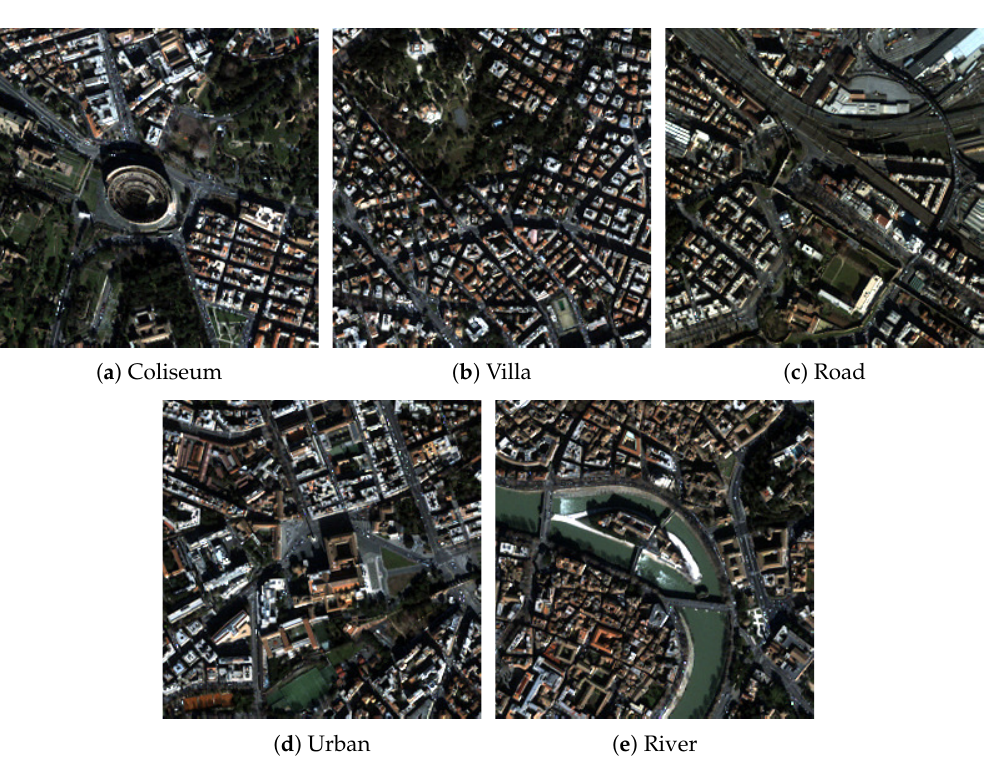
Figure 1. Reference undistorted multi-spectral images scenes used for the subjective study obtained from